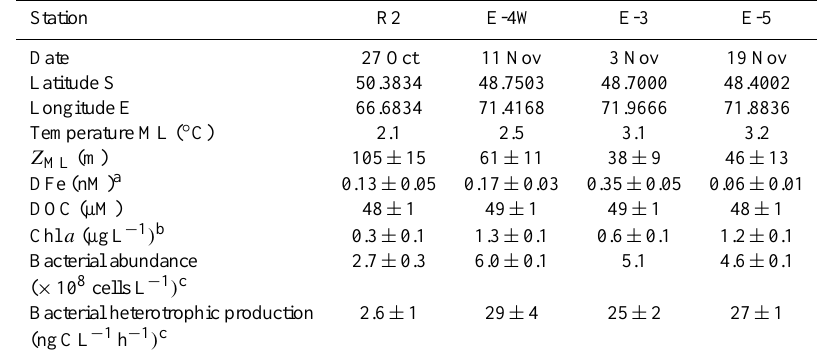
Table 1. Date, location and environmental characteristics of the study sites. Values are mean ± SD of the mixed layer